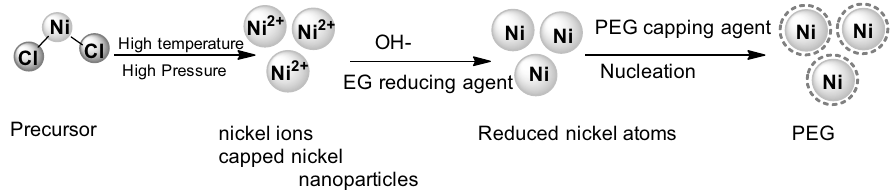
Figure 11: Schematic representation of the solvothermal